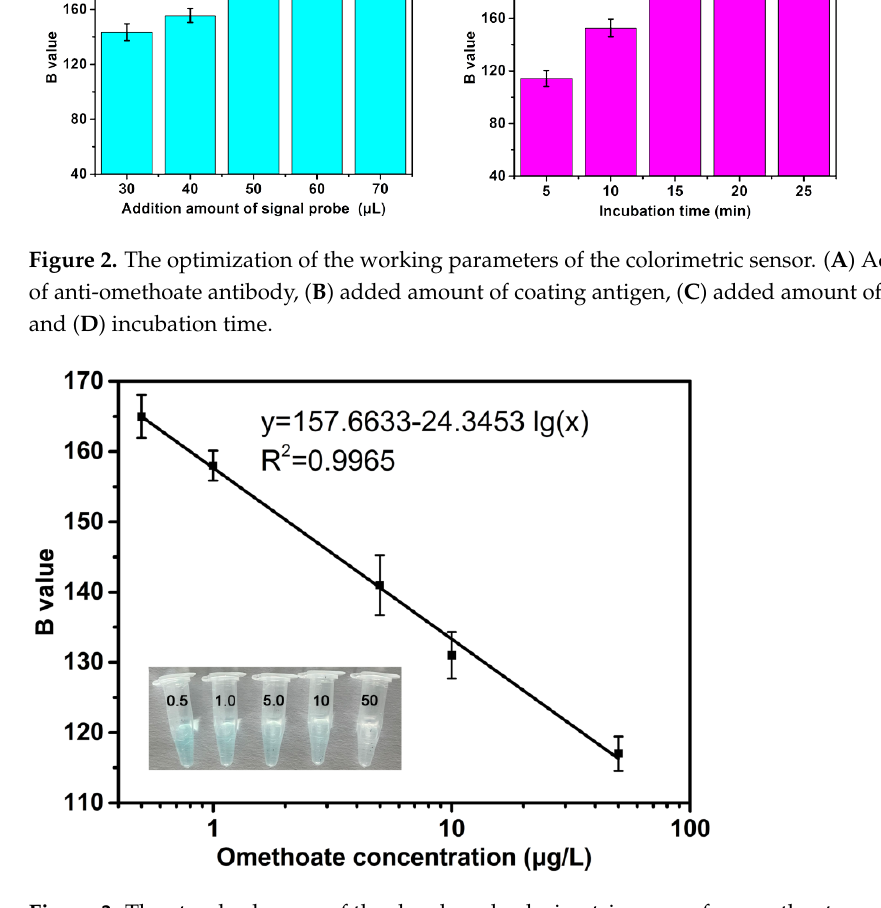
Figure 3. The standard curve of the developed colorimetric sensor for omethoate; and inset: color development images at omethoate concentrations of 0.5~50 μ g/L.